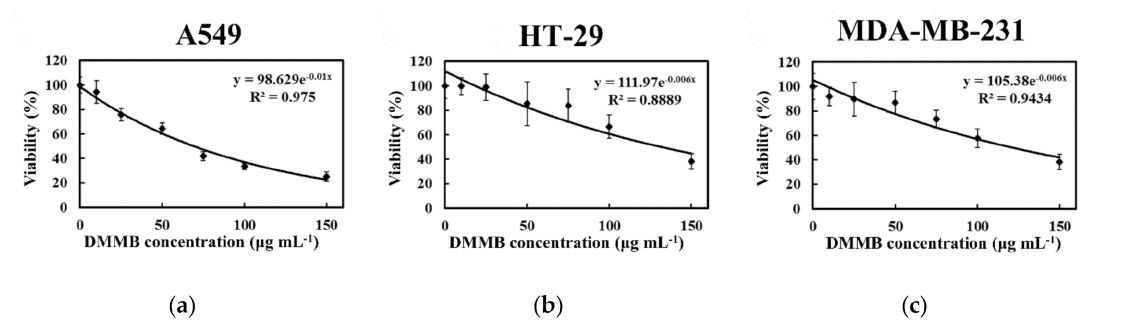
Figure 6. Effects of DMMB on cancer cells. After treated with DMMB, the viabilities of ( a ) A549, ( b ) HT-29, and ( c ) MDA-MB-231 cells were analyzed according to the formazan-based cell proliferation reagent WST-1 assay. Each value is expressed as the mean ± SD ( n = 3).